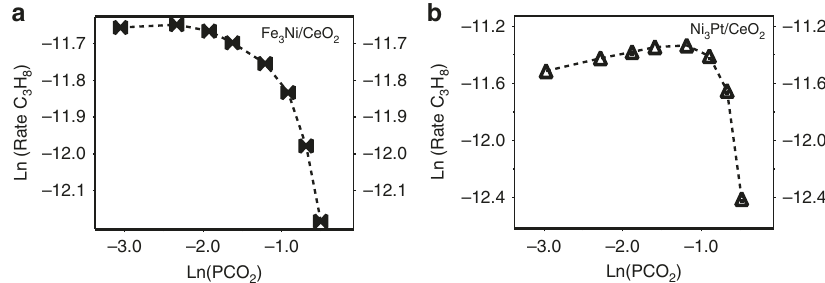
Fig. 2 Effect of CO 2 partial pressure on the propane production rate. Plots for a Fe 3 Ni and b Ni 3 Pt. Total system pressure is 1 atm